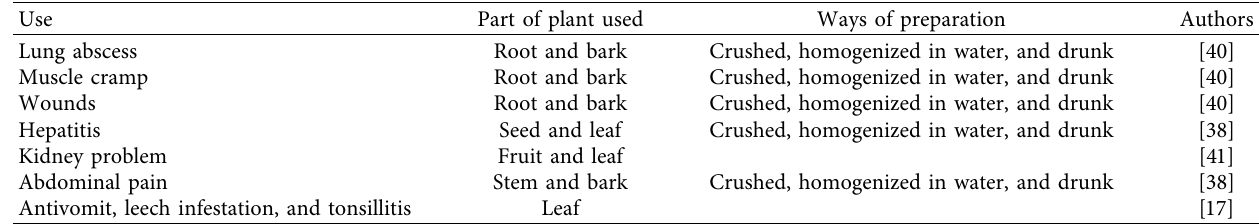
Table 1: Traditional medicinal uses and parts used of Ximenia americana in